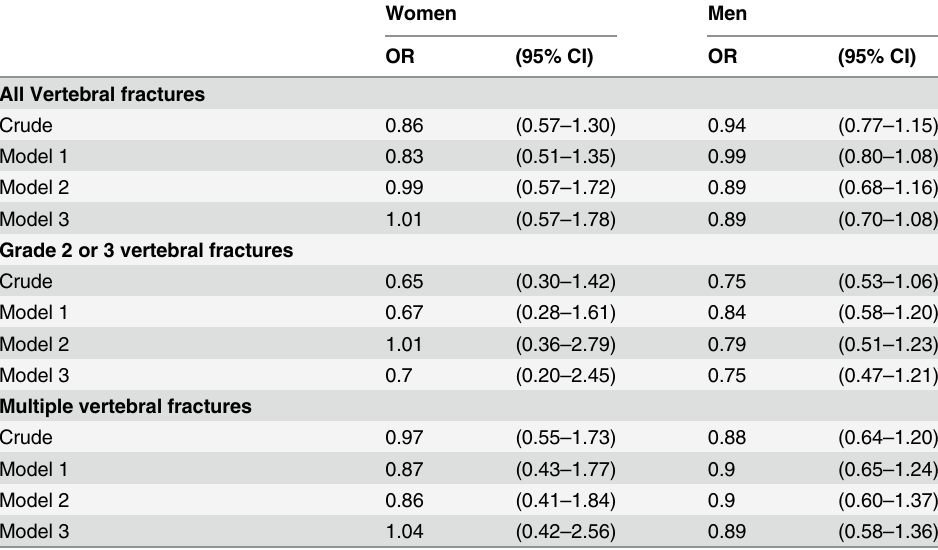
Table 5. Associations between the presence of vertebral fractures by various definitions and the ver- tebral strength